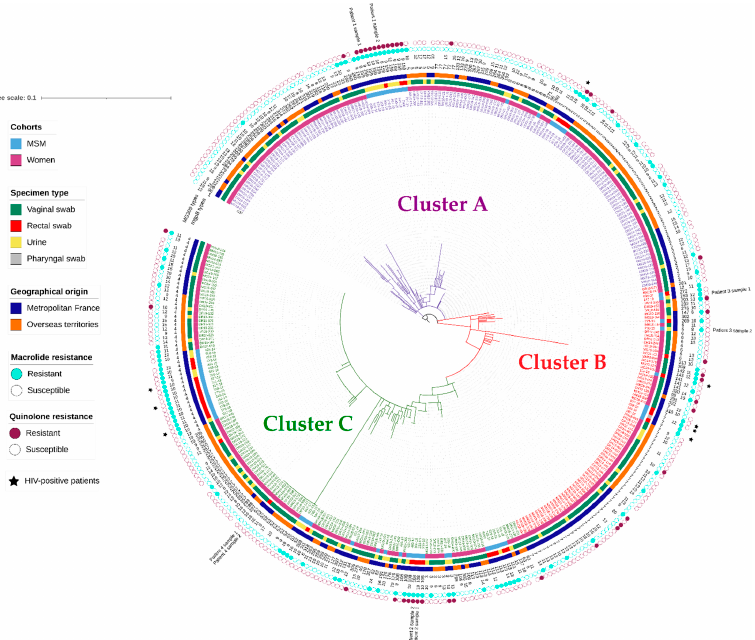
Figure 1. Maximum likelihood tree based on the mgpB type of the 374 M. genitalium strains collected from 305 women and 65 MSM. The tree was constructed using a T92 G+I model. Branch support values were generated from 1000 bootstrap replicates. The sequence of the M. genitalium G37 strain was used as a reference. The phylogenetic tree was annotated with (from the centre to the outside) the strain name, the cohort, the individual geographical origin, the sampling site, the mgpB sequence type (from 1 to 323), the MG309-STR type of the strain (from 8 to 20, if available), and the macrolide and fluoroquinolone resistance profile of the strain (if available). Clusters A, B, and C are repre- sented by branches and strain names in purple, red, and green, respectively. Concurrent or subse- quent samples from four patients are highlighted. HIV-positive patients are symbolized by a black star. For better reading, a clearer figure is available as supplementary data file (Figure S1).